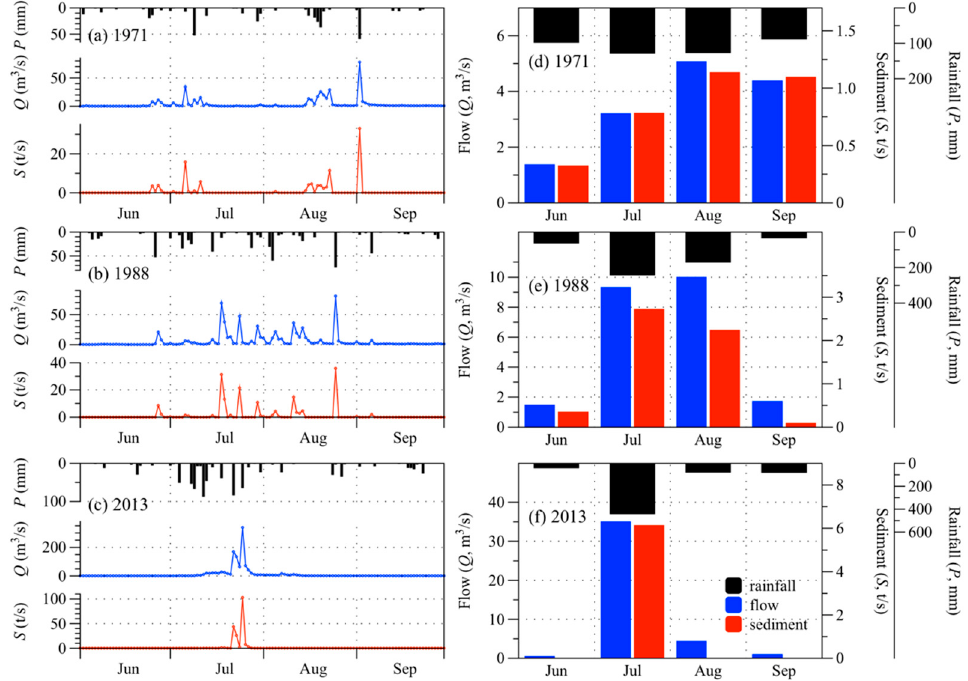
Figure 4. Daily (panels a – c ) and monthly (panels d – f ) rainfall, streamflow, and sediment discharge of the Yunyan River Basin for the 1971, 1988, and 2013 flood seasons. Daily rainfall series is from the observations at Yan’an rain gauge (109°27 ′ E, 36°35 ′ N, 15 km northwest of the basin), while monthly rainfall series is from the 0.5 Degree Gridded Dataset. Streamflow and sediment load are measured at the Xinshihe hydrological station. The unit of rainfall represents the total amount, while the units of flow and sediment discharge represent the average.